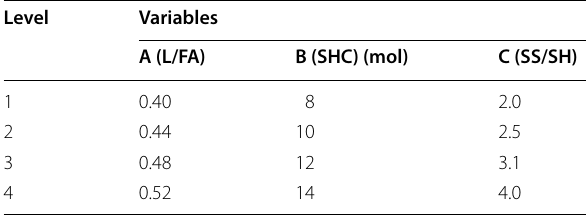
Table 3 The mix design variables.